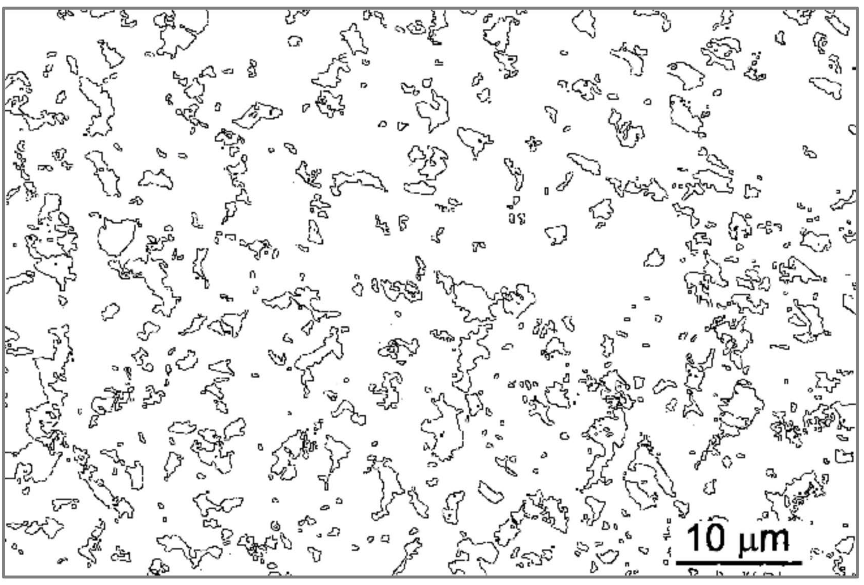
Figure 10. ( a ) XRD patterns of manufactured porous ceramics, illustration of the ( b ) (110) peak, and ( c ) the (210), (120) doublet of mullite.